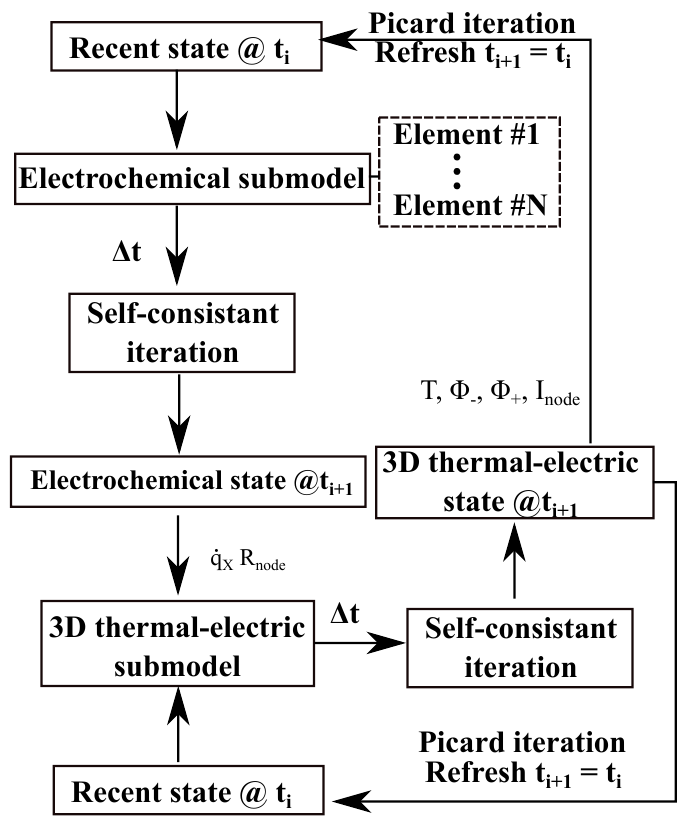
Figure 3. Illustration of the computational algorithm for the 3D multiphysics